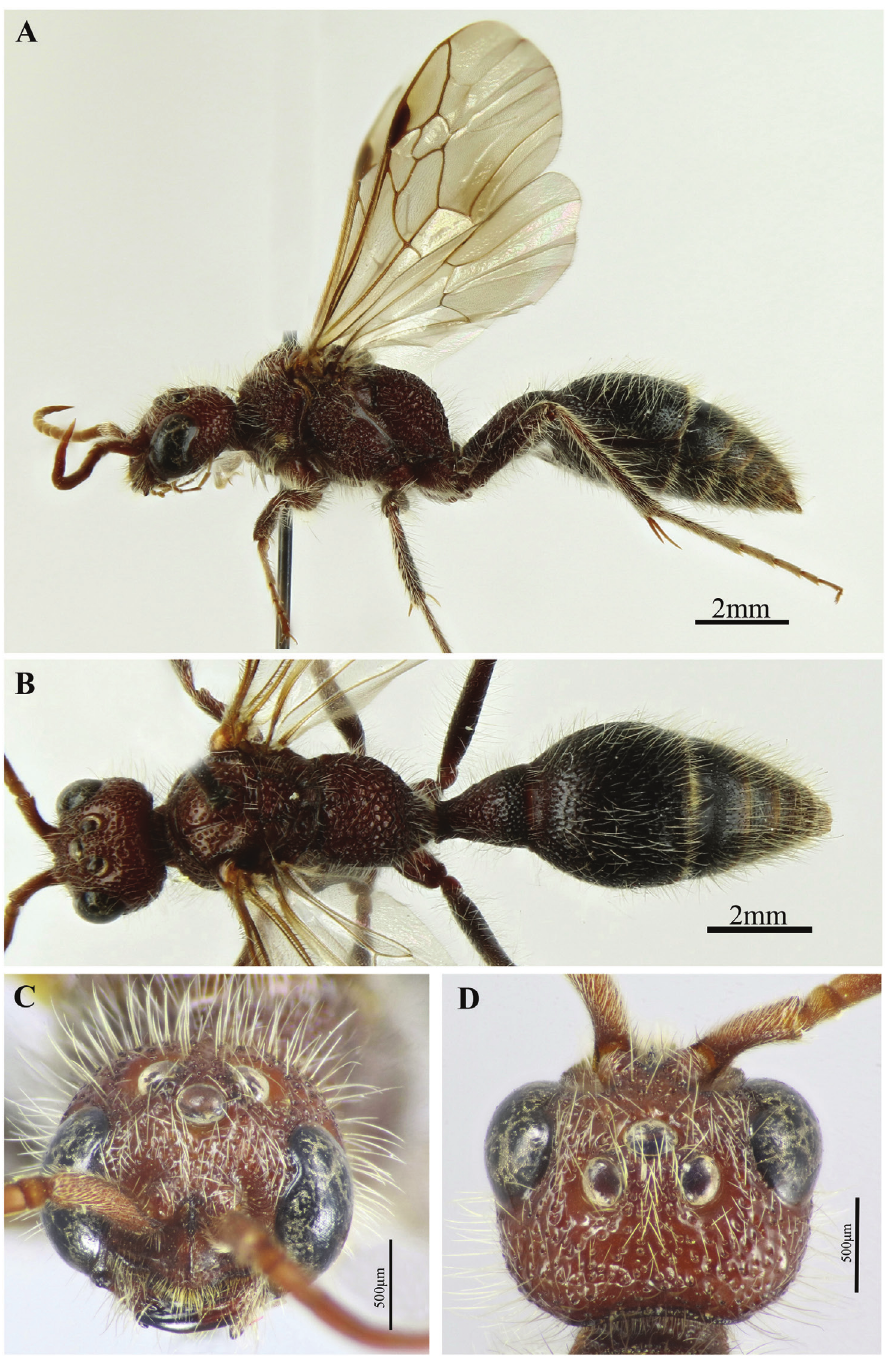
Figure 15. Pseudophotopsis mascatiana Invrea (Male) A, B habitus, lateral and dorsal views, respectively C head, frontal view D head and antennal scape, dorsal